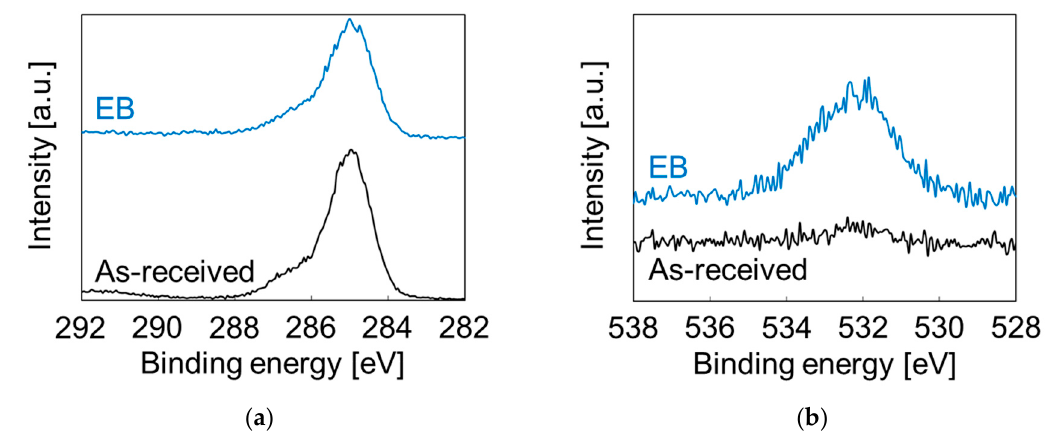
Figure 7. X-ray photoelectron spectroscopy (XPS) spectra of the ABS surface before and after irradiation by an electron beam in water: ( a ) C1s and ( b ) O1s. by an electron beam in water: ( a ) C1s and ( b )